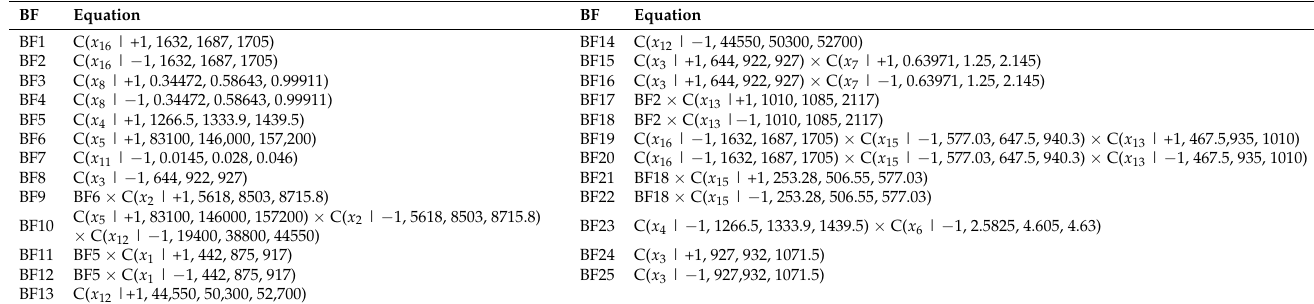
Table 9. Basis functions of the piecewise-cubic MARS model of carbon concentration in melt.